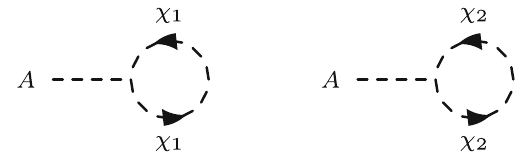
Fig. 1 Feynman diagrams contributing to the one-loop tadpole of the CP odd